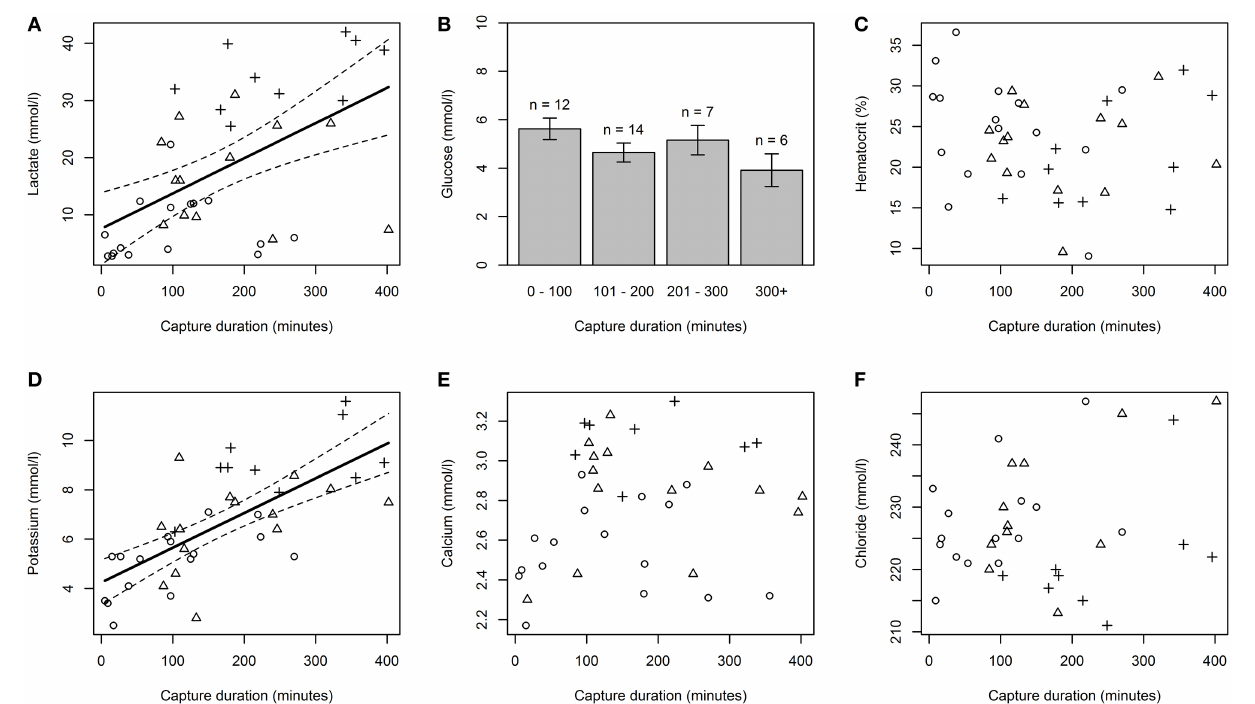
FIGURE 1 | The effect of capture duration on physiological response variables. Physiological variables examined include plasma lactate (A) , plasma glucose (B) , hematocrit (C) , plasma potassium (D) , plasma calcium (E) , and plasma chloride (F) . Solid lines in plasma lactate and potassium plots represent a statistically significant linear relationship between capture duration and the physiological variable examined. Dashed lines represent 95% confidence intervals. Glucose was binned using 100min intervals because the variable deviated significantly from a normal distribution. Circles, triangles, and crosses symbolize sharks caught in a “healthy,” “sluggish,” and “moribund or dead” condition